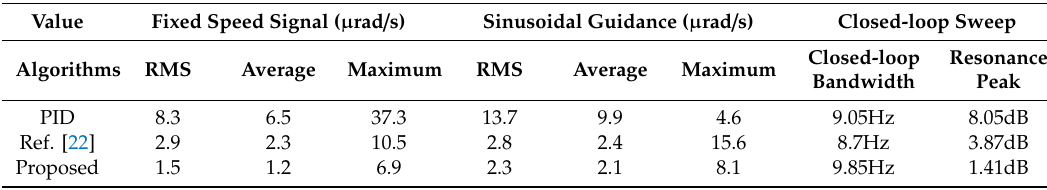
Table 1. Summary of experimental